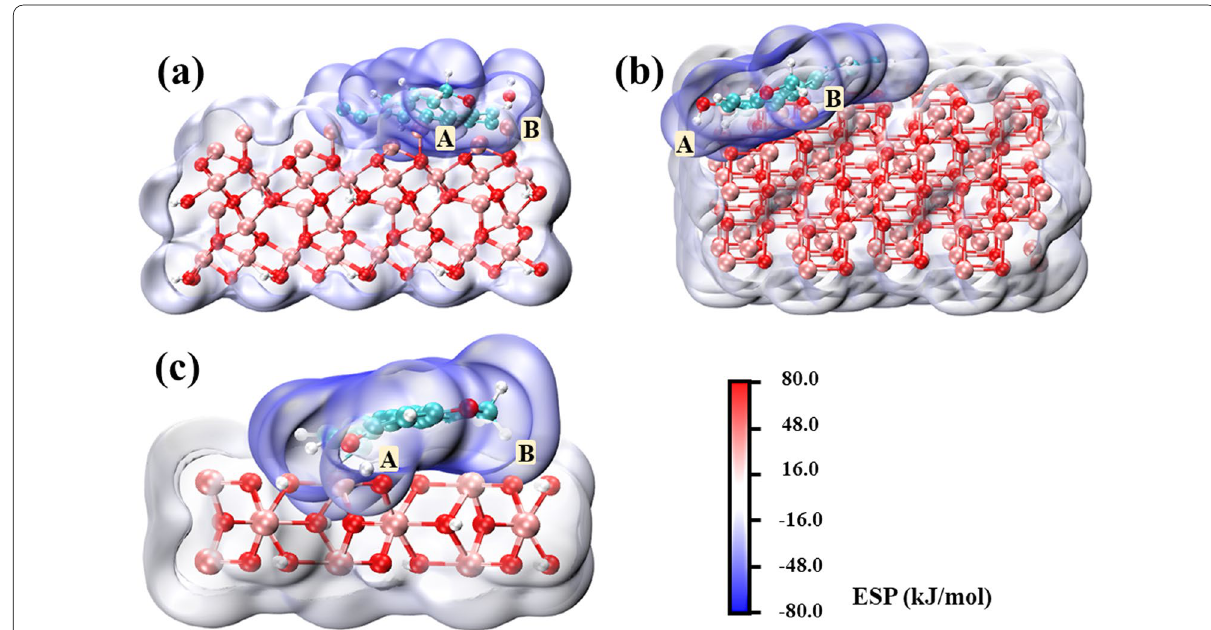
Fig. 5 Cluster model of the structures of BCNPs and IMNPs: BCNPs-FHNPs ( a ), BCNPs-MTNPs ( b ), and BCNPs-GTNPs ( c ). The blue-green, white, red, and pink spheres represent C, O, H, and Fe, respectively. ESP indicates the electrostatic potential of the macromolecule, wherein red and blue are the positive and negative areas, respectively. Two key regions (A and B) were identified for each cluster model. Their vertex coordinates and interpenetration distances are shown in Additional file 1: Table S5. The binding energies between the BCNPs and IMNPs are shown in